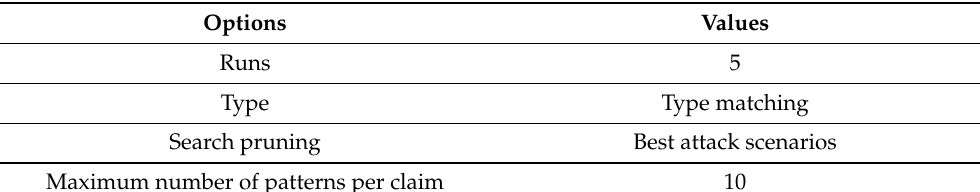
Table 4. Scyther’s configuration detail for the